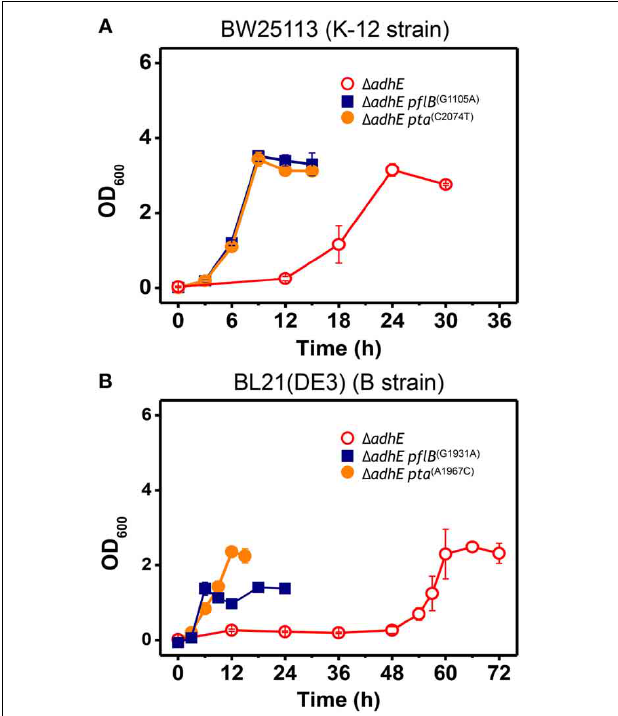
FIGURE 6 | Accelerated growth of (cid:2) adhE mutants of E. coli K-12 and B strains by introduction of pta or pflB point mutations. (A) BW25113 (cid:2) adhE cells carrying the pflB (G1105A) or pta (C2074T) mutation in the genome instead of the authentic pflB or pta gene, and (B) BL21(DE3) (cid:2) adhE cells carrying pflB (G1931A) or pta (A1967C) . FIGURE 7 | Repeated sequence mediated insertions and deletions in